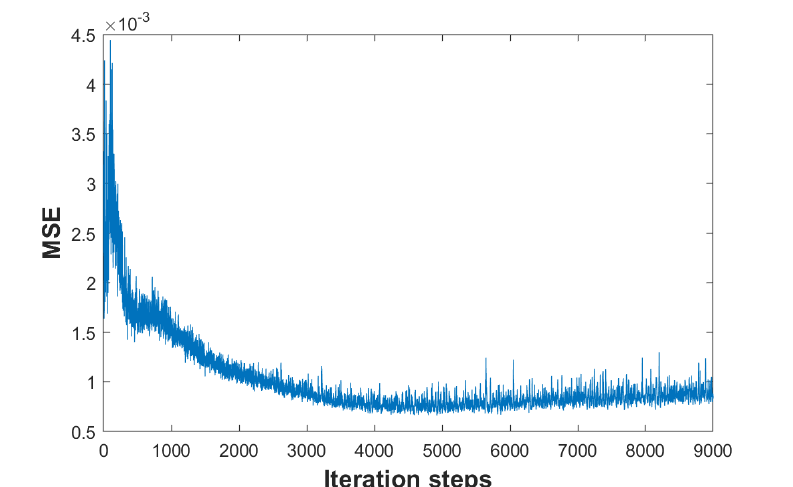
Figure 2. Variations in the MSE between the network outputs obtained from two DIP optimization processes along iteration